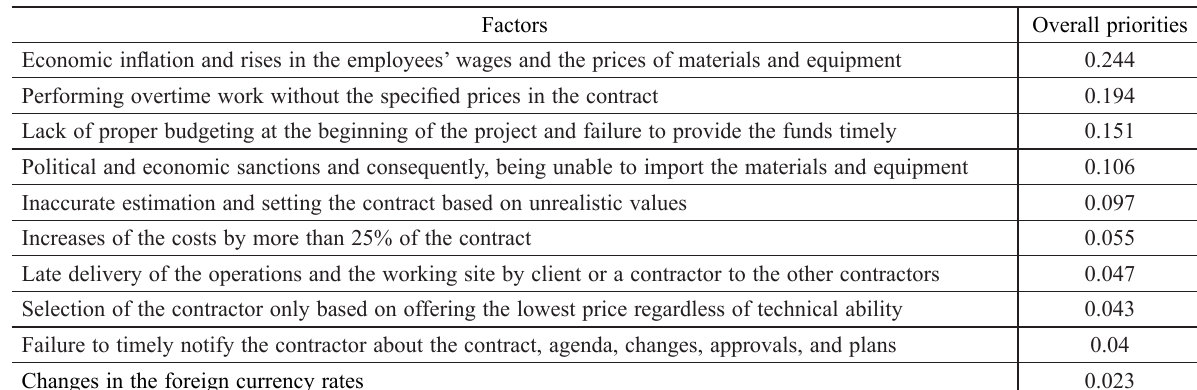
Table 2. The overall priorities of the factors effective in the development of the cost and time claims